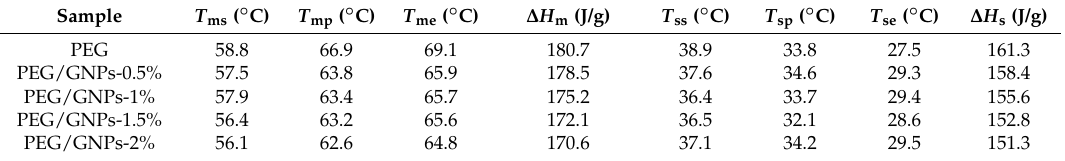
Figure 6. The latent heat and thermal conductivity of the composite as a function of GNPs contents. Table 2. Calculated and measured values of the melting latent heat of composites.